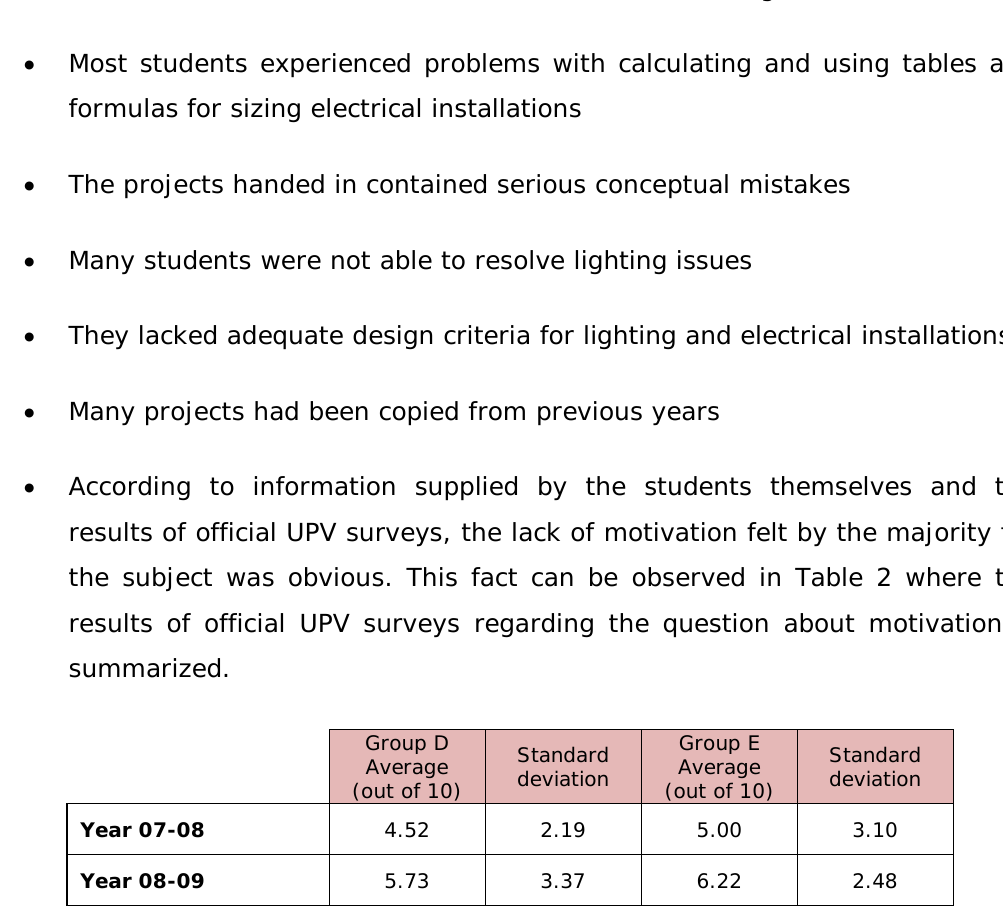
Table 2. “Results about the question “ The methodology employed is motivating ”, formulated in the official UPV surveys of the previous academic years 07-08 and 08-09 of the groups D and E”. Source: